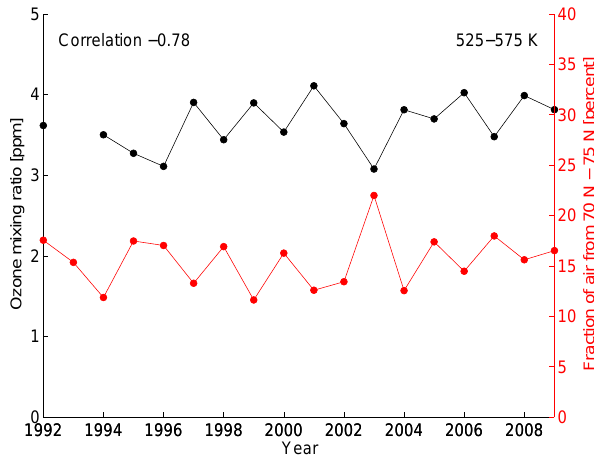
Fig. 6. Time series of vortex mean ozone mixing ratios at 525– 575K in early winter (30 December–8 January, 1992–2009, black), superimposed by a time series of the fraction of air in the polar vortex at 525–575K which is originating south of 30 ◦ N equivalent latitude on 1 September (red).